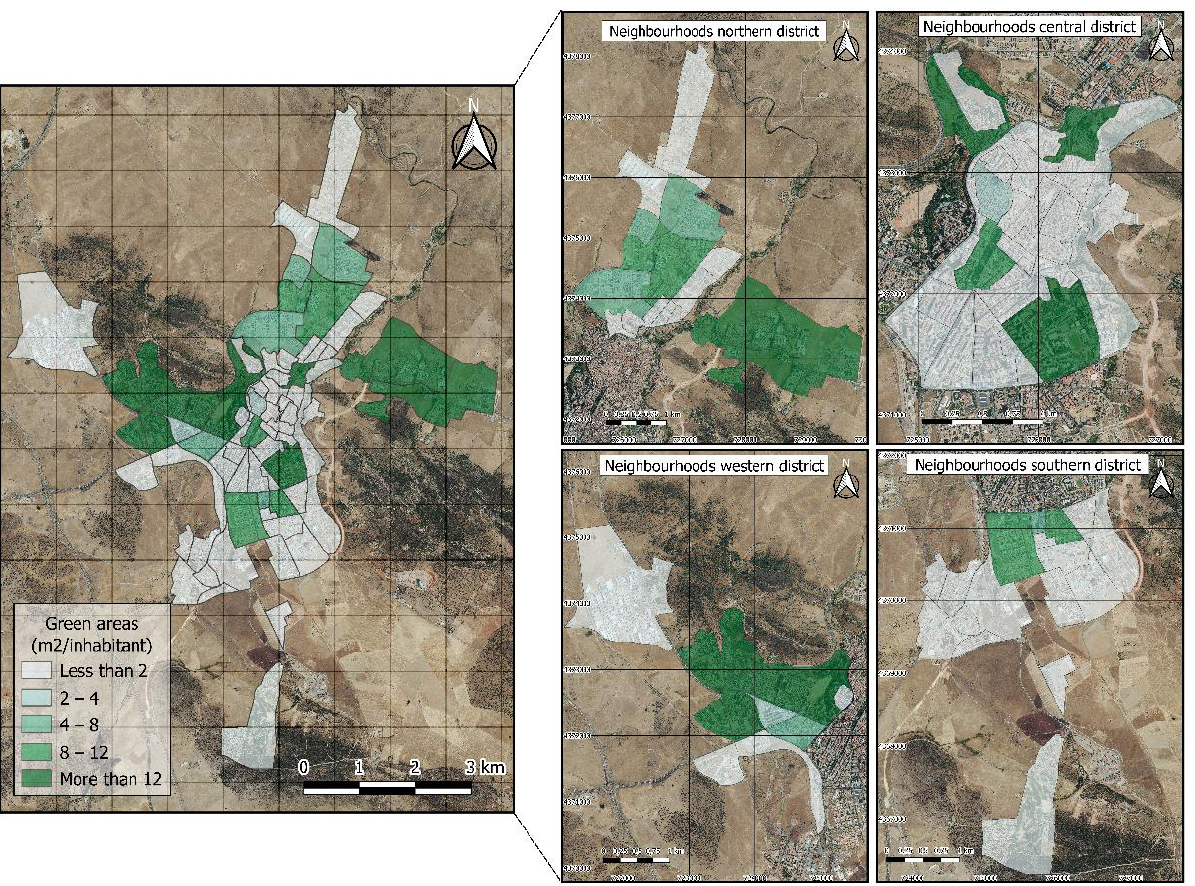
Figure 6. Area of green space per inhabitant.